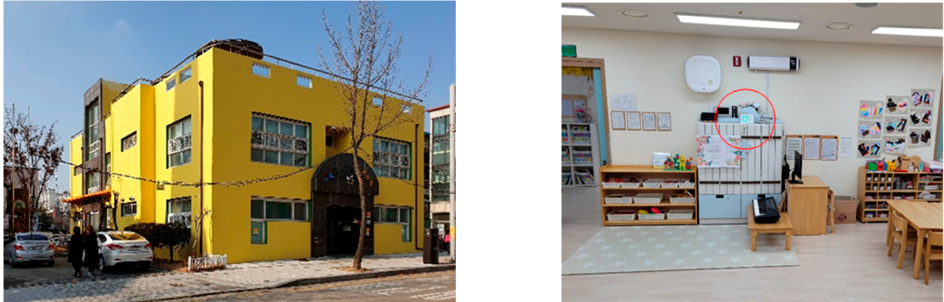
Figure 1. The view of the childcare center ( left ) and inside the childcare room with the multiple monitoring sensor installed ( right ).